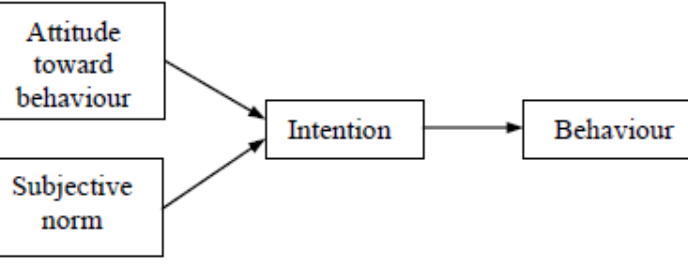
Figure 1. The theory of reasoned action (Fishbein & Ajzen. 1975)